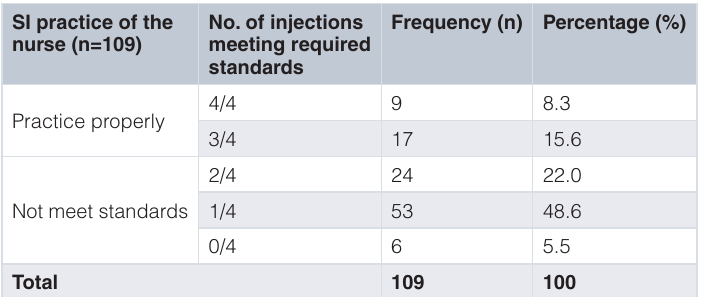
Table 4. Percentage of nurses having correct safe injection procedure